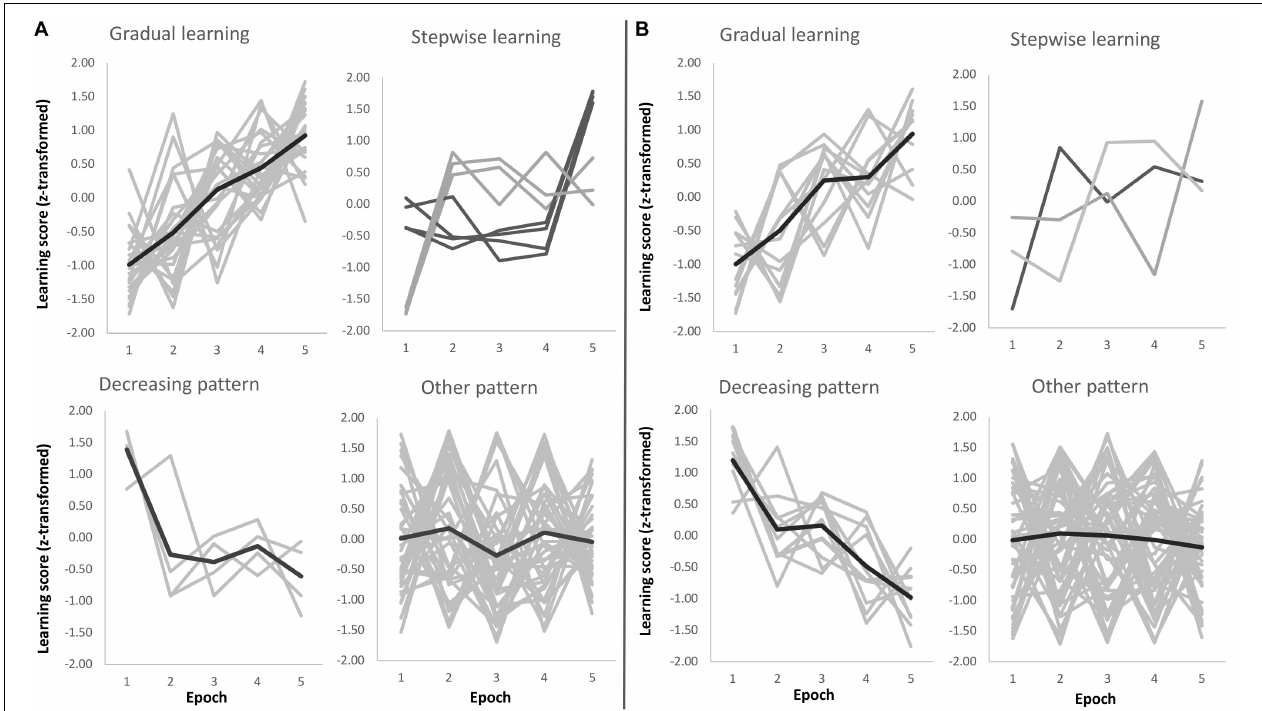
FIGURE 4 | Sequence (A) and Statistical (B) learning trajectories for individual subjects. Each participant’s learning trajectory is presented in a light gray color, while the average learning trajectory for that subgroup is presented in a darker gray color for the ‘Gradual learning,’ ‘Decreasing pattern,’ and ‘Other pattern’ panels. For the ‘Stepwise learning’ panel, the light and dark gray colors represent subgroups of participants depending on the timing of their performance increase (no average learning trajectory is presented).